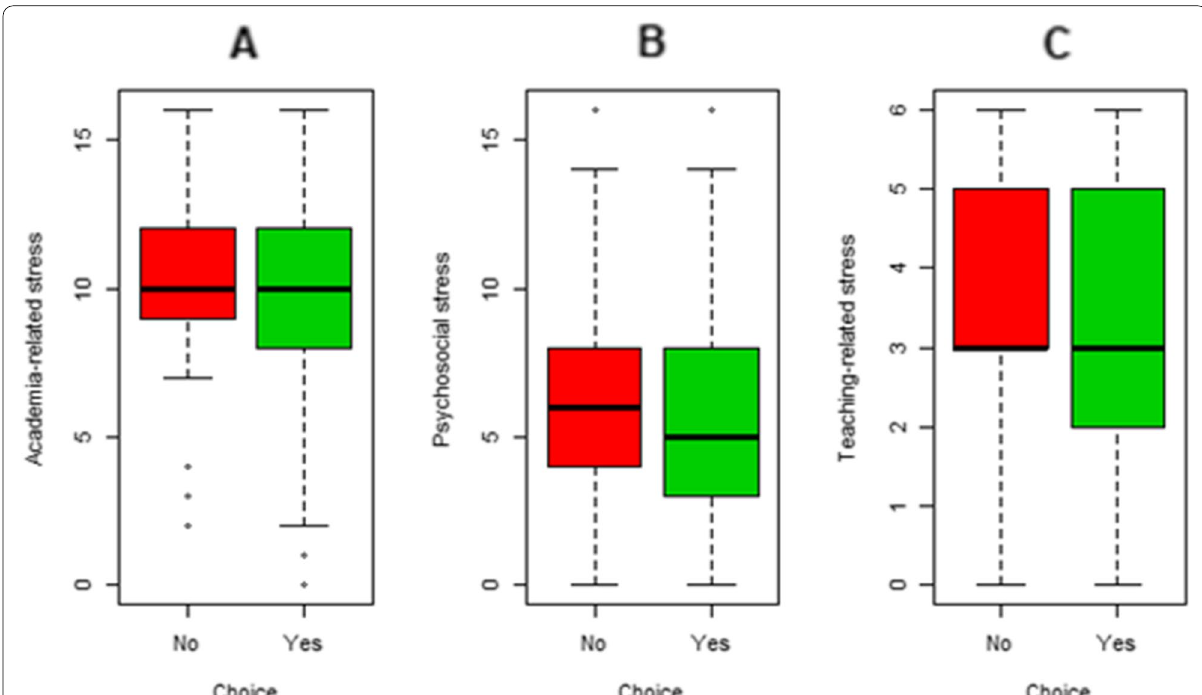
Fig. 3 Academic, psychosocial, and teaching-related stressors broken up by student choice of medical career. The box-and-whisker plots represent the stress scores ( A Academic, B Psychosocial, C Teaching-related) broken-up by student choice of medical career. Note that the borders of the box represent the first and third quartiles (width indicates the interquartile range) and the whisker terminals represent the maximum and minimum score. The median score is represented by the thick black line in the middle of the box. Students that did not choose to study medicine were more stressed than males in terms of psychosocial stress domain